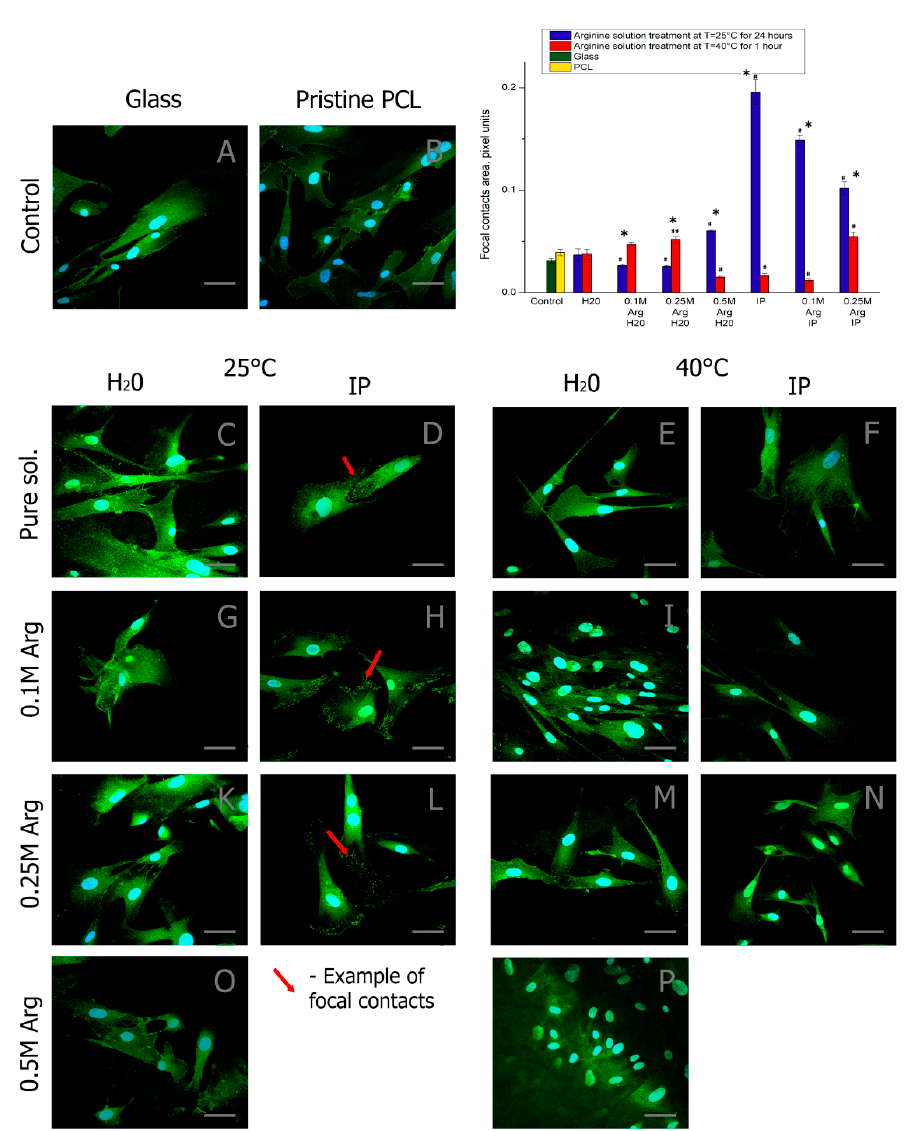
Figure 6. Fluorescence micrographs of MSCs with vinculin (green) and nuclei (blue) stained after three days of cultivation: ( A ) on the pure glass, ( B ) on the pristine PCL, ( C ) on the film treated with water for 24 h at T = 25 °C, ( D ) on the film treated with water/isopropanol (3:1) for 24 h at T = 25 °C, ( E ) on the film treated with water for 1 h at T = 40 °C, ( F ) on the film treated with water/isopropanol (3:1) for 1 h at T = 40 °C, ( G ) on the film treated with the 0.1 M arginine solution in water for 24 h at T = 25 °C, ( H ) on the film treated with the 0.1 M arginine solution in water/isopropanol (3:1) for 24 h at T = 25 °C, ( I ) on the film treated with the 0.1 M arginine solution in water for 1 h at T = 40 °C, ( J ) on the film treated with the 0.1 M arginine solution in water/isopropanol (3:1) for 1 h at T = 40 °C, ( K ) on the film treated with the 0.25 M arginine solution in water for 24 h at T = 25 °C, ( L ) on the film treated with the 0.25 M arginine solution in water/isopropanol (3:1) for 24 h at T = 25 °C, ( M ) on the film treated with the 0.25 M arginine solution in water for 1 h at T = 40 °C, ( N ) on the film treated with the 0.25 M arginine solution in water/isopropanol (3:1) for 1 h at T = 40 °C, ( O ) on the film treated with the 0.5 M arginine solution in water for 24 h at T = 25 °C, ( P ) on the film treated with the 0,5 M arginine solution in water for 1 h at T = 40 °C. Statistics of cell adhesion on surfaces with different functional groups after 1 day cultivation. ( n = 5: *— p < 0.01, for the same concentration data, #— p < 0.01, ##— p < 0.05 compared with the unmodified PCL). Scale bar 50 µm. 3. Materials and Methods